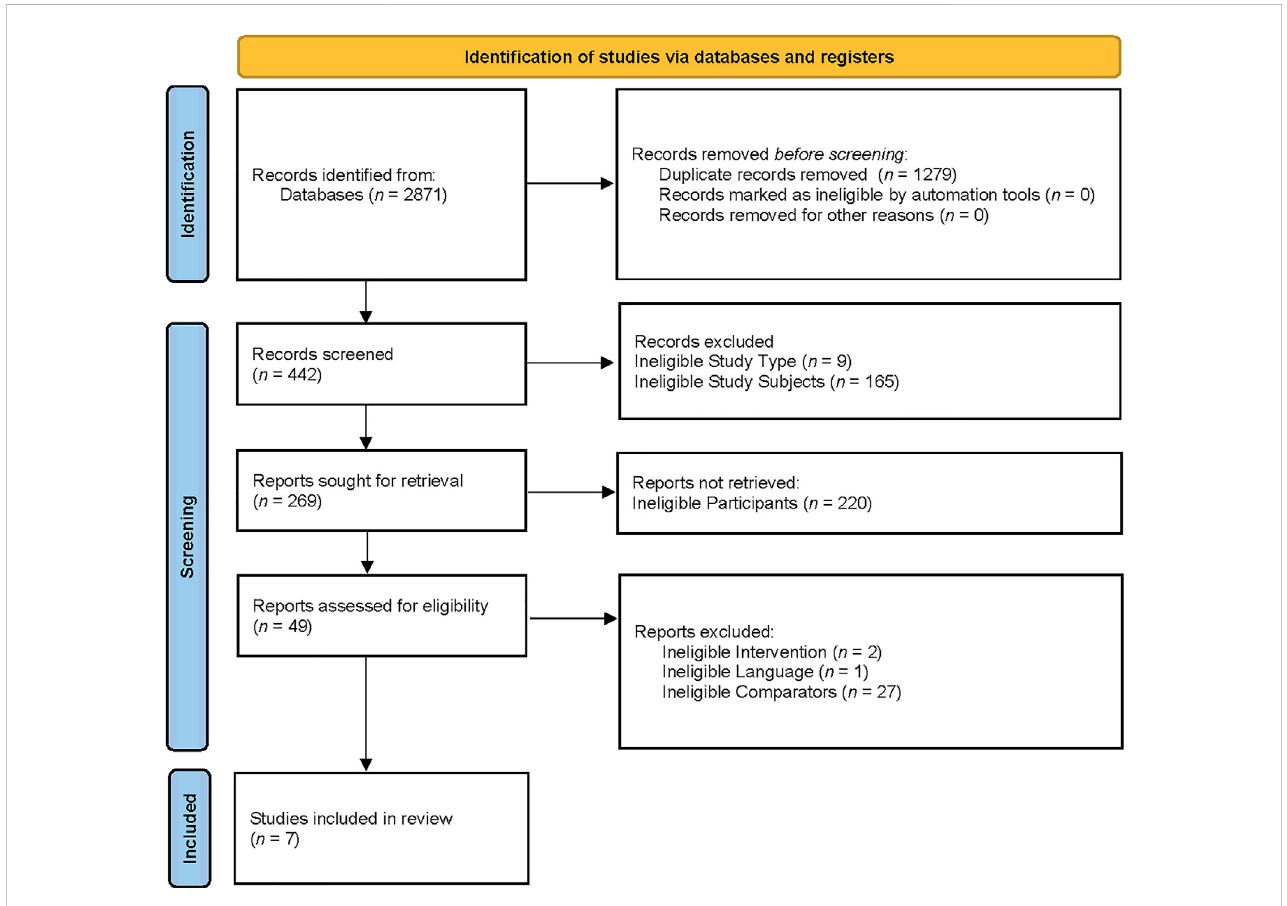
FIGURE 1 The PRISMA 2020 fl ow diagram for new systematic reviews which included searches of databases and registers only.